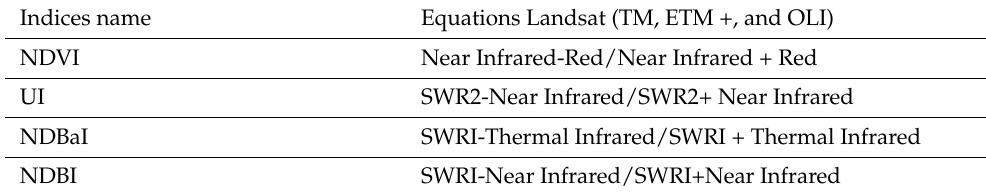
Table 2. Formulas for various LULC